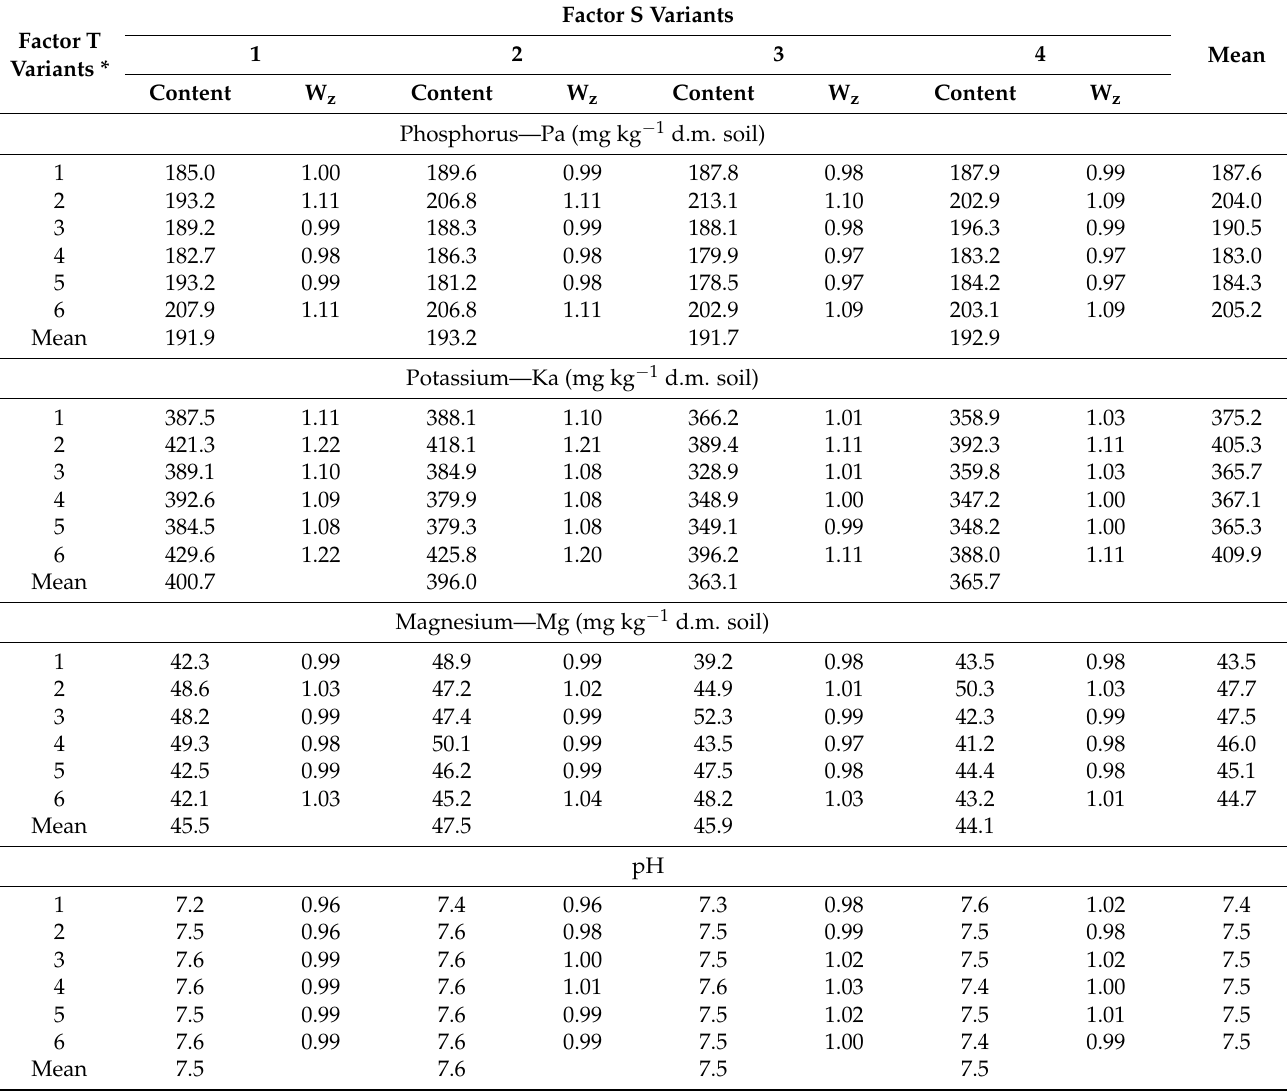
Table 3. Soil phosphorus Pa, potassium Ka, and magnesium Mg (mg kg − 1 d.m.) content, and pH of the soil, depending on tillage method (factor T) and stubble management (factor S) in spring wheat